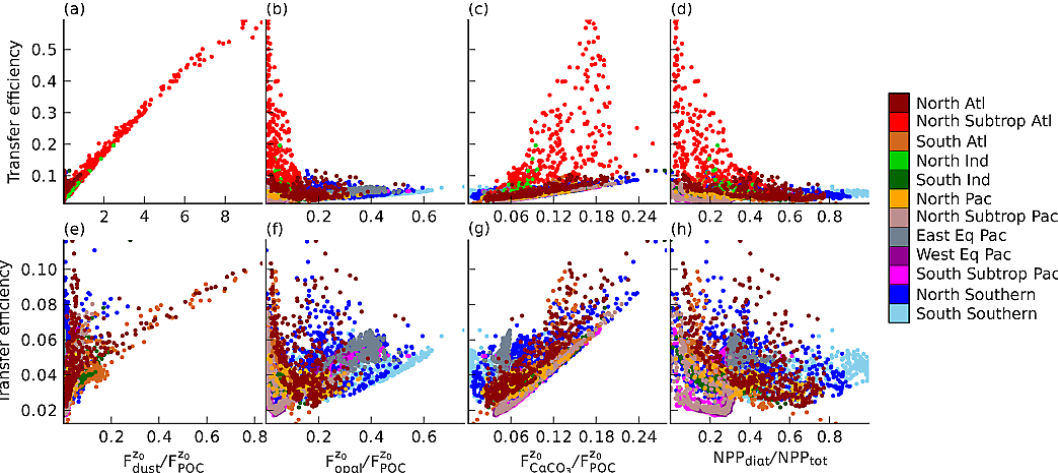
Fig. 9. Transfer efficiency (ratio of POC flux at 2000m to POC flux at z 0 ) plotted against the ratio of dust (a, e) , opal (b, f) and CaCO 3 (c, g) fluxes to POC flux at export depth ( z 0 ), and the ratio of vertically integrated NPP by diatoms to total NPP (d, h) . In (e–h) , the regions of high atmospheric dust deposition (northern subtropical Atlantic and northern Indian Ocean) have been removed.